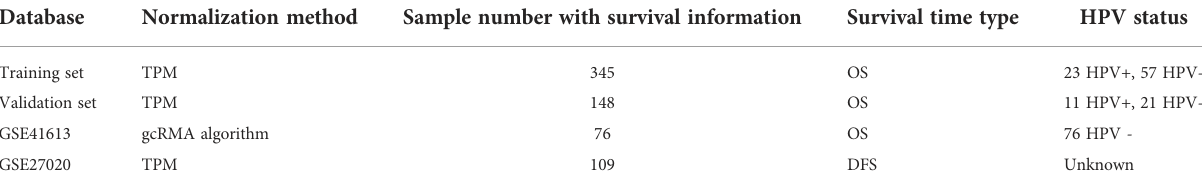
TABLE 1 Sample information in the